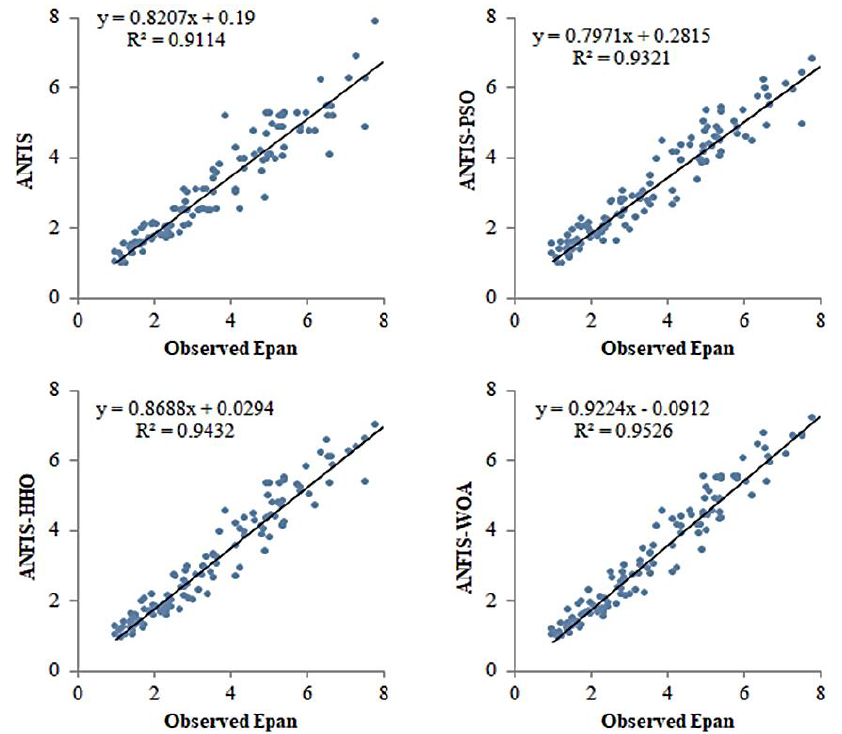
Figure 4. Scatterplots of the observed and predicted Epan using the hybridized ANFIS models in the testing phase using the best input combination—Nanxian Station.